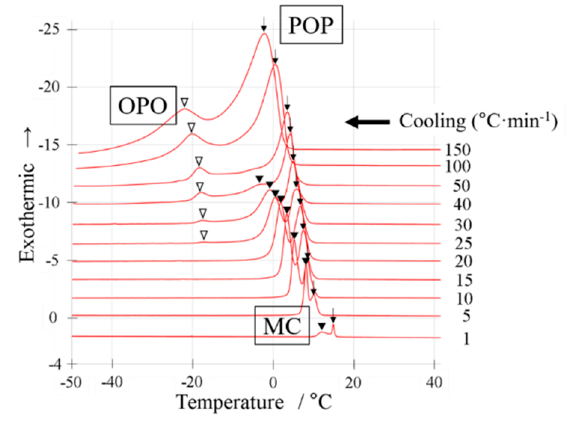
Figure 2. Differential scanning calorimetry (DSC) cooling thermograms with a binary mixture of OPO/POP = 4/6. The x-axis shows temperature. The y-axis shows normalized exothermic heat flow. The thermograms overlay at cooling rate of 1~150 °C min − 1 from bottom to top. The open triangles indicate OPO crystallization. The closed triangles indicate MC crystallization. The arrows indicate POP crystallization.